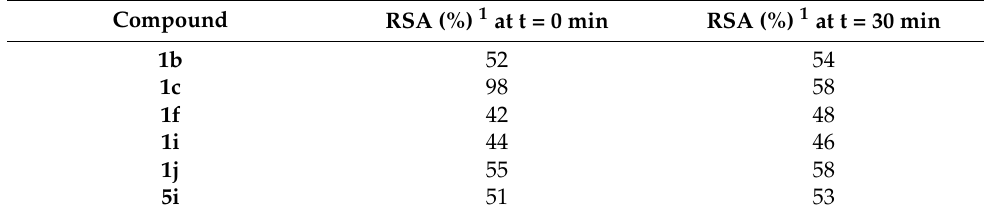
Table 6. Antioxidant activity of some of the synthesized